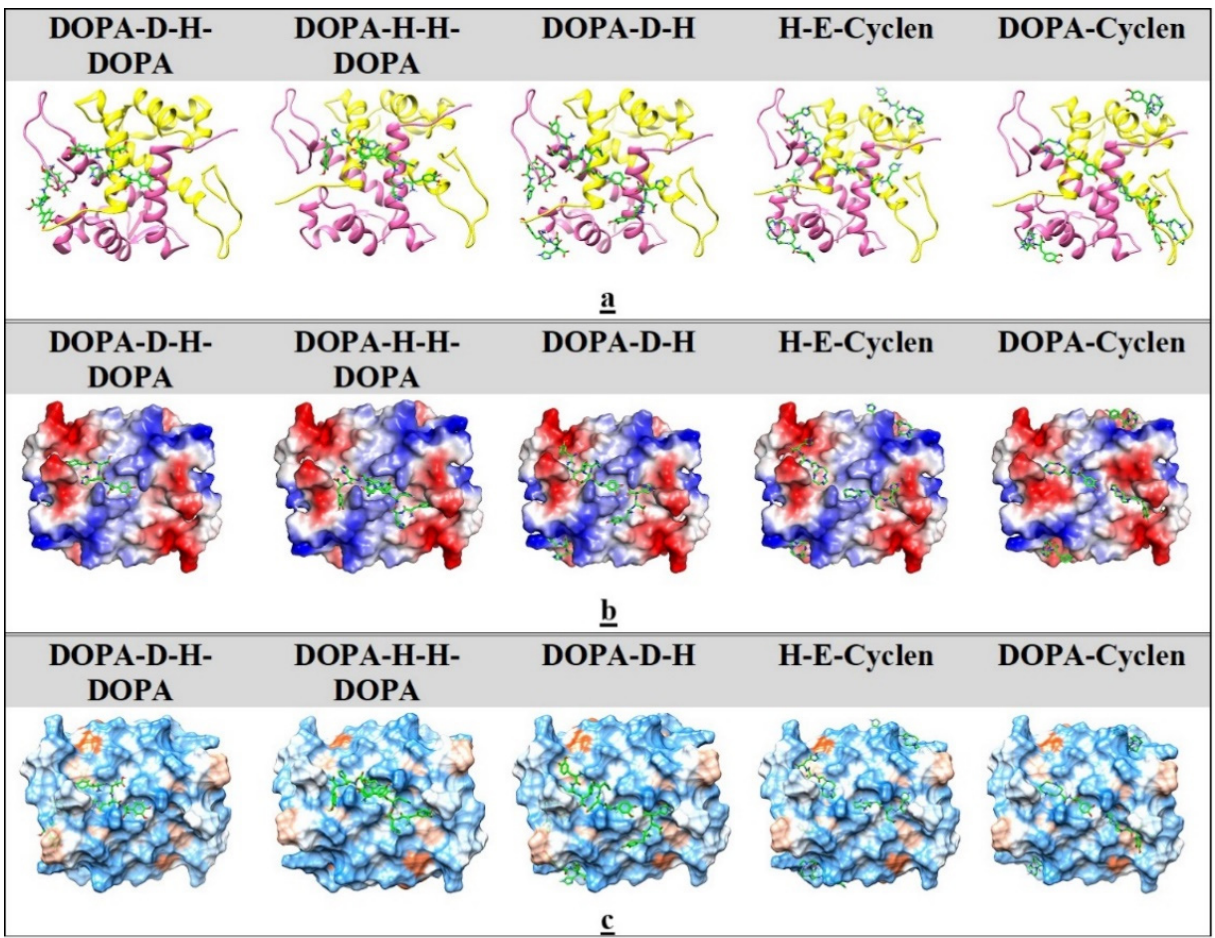
Figure 5. Binding sites on S100A9 homodimer for corresponding DOPA and cyclen-based compounds derived from molecular docking studies. ( a ) Ribbon diagrams of S100A9 homodimer with corresponding bound compounds, depicting the positions of the bound ligands on their surface. S100A9 monomers are depicted as yellow and pink ribbons and denoted as chains A and B, respectively. The ligands are depicted by green sticks in all images in ( a – c ). ( b ) Connolly surface electric potential models of S100A9 homodimers with corresponding bound compounds. Electric potentials are depicted on scale from − 8 to 8 k B T/e in red-white-blue colors (red shows the negative extreme in electrostatic potential, blue the positive extreme, and white the non-polar regions). ( c ) Connolly surface polarity models of S100A9 homodimer with the corresponding bound compounds depicting hydrophilic (in light blue), intermediate (in white), and hydrophobic (in orange) patches on its surface. The bound compounds are indicated in the figure caption above the corresponding images.